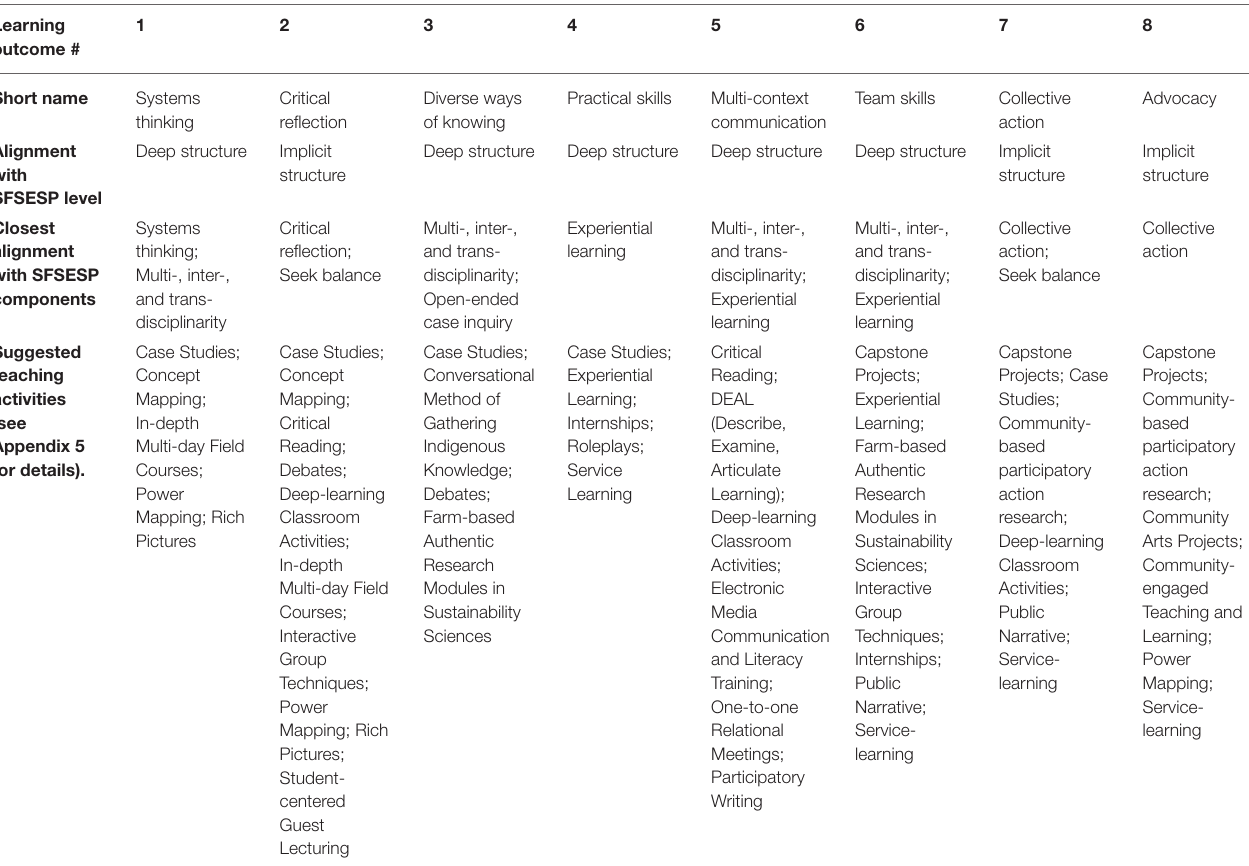
TABLE 1 | Adaptable Program Learning Outcomes for Sustainable Food Systems Education, their alignment with the SFSESP Framework, and teaching activities for supporting these LOs. Learning outcome